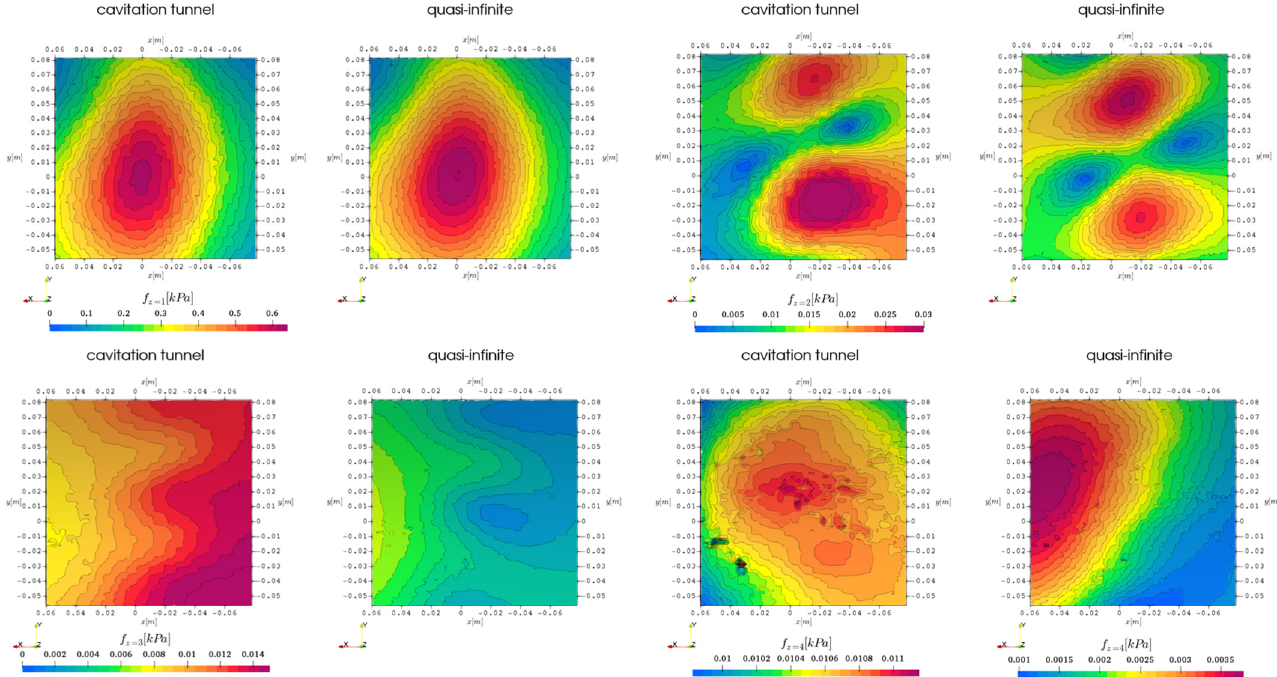
Figure 3. First 4 harmonic propeller blade frequencies incompressible hull pressure above propeller, comparison of domain extent, RANS without cavitation.